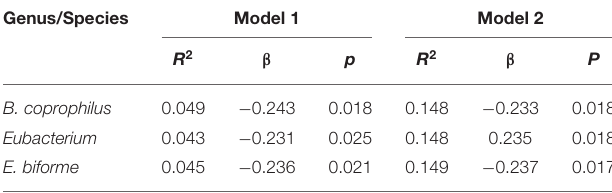
TABLE 2 | Association between intestinal bacteria and HDL/LDL